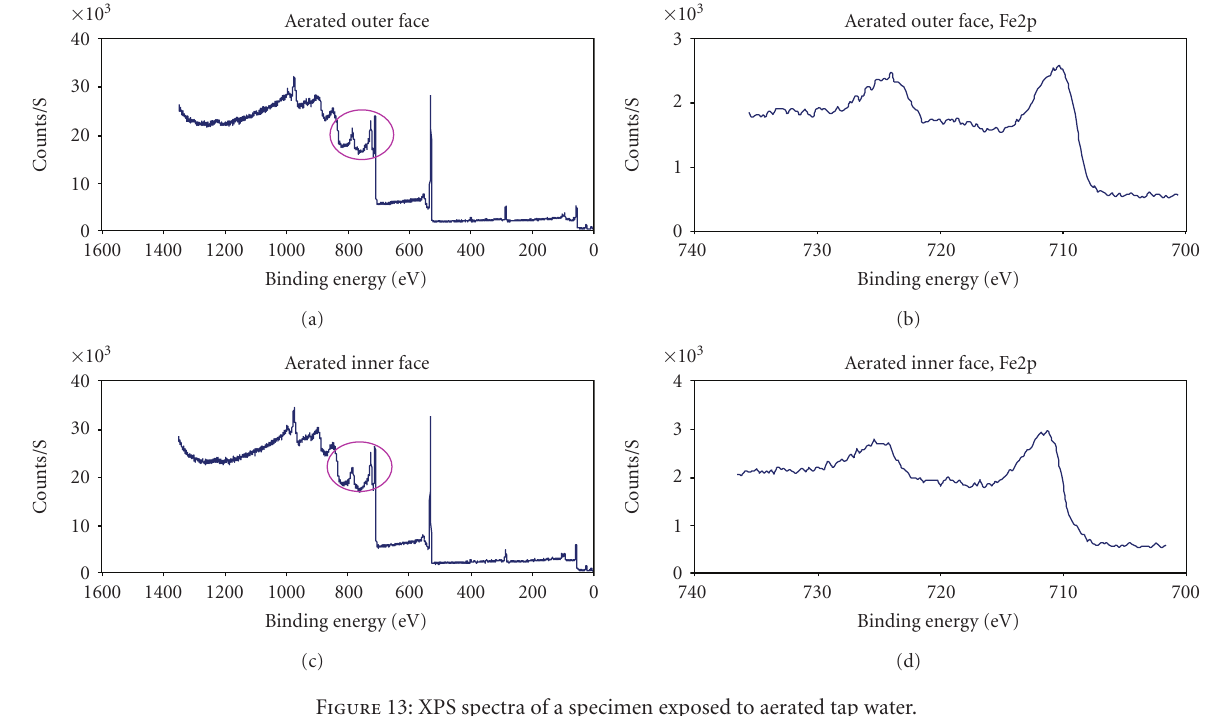
Figure 13: XPS spectra of a specimen exposed to aerated tap water.